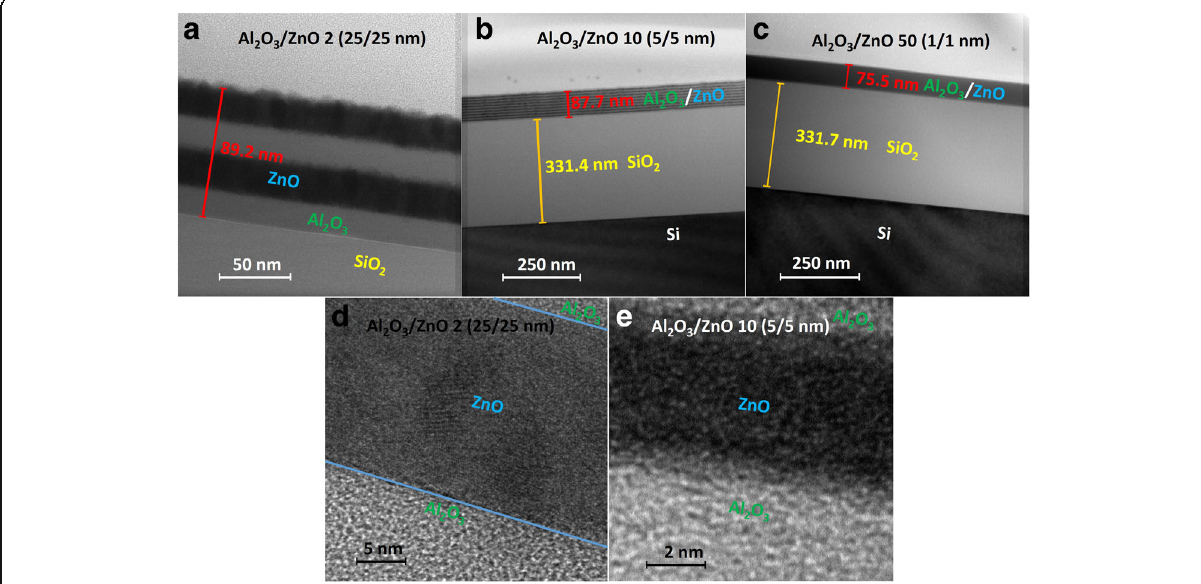
Fig. 2 TEM images of Al 2 O 3 /ZnO nanolaminates with different bilayer thicknesses: a 50 nm, b 10 nm, and c 2 nm. And high-magnification images: d 50 nm and e 10